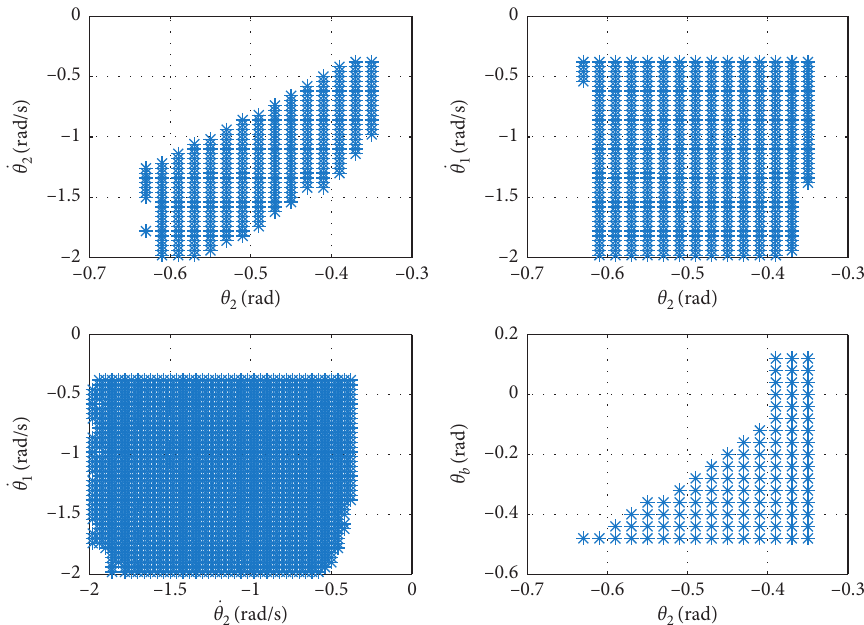
Figure 10: Basin of attraction of the CPG-based biped for u